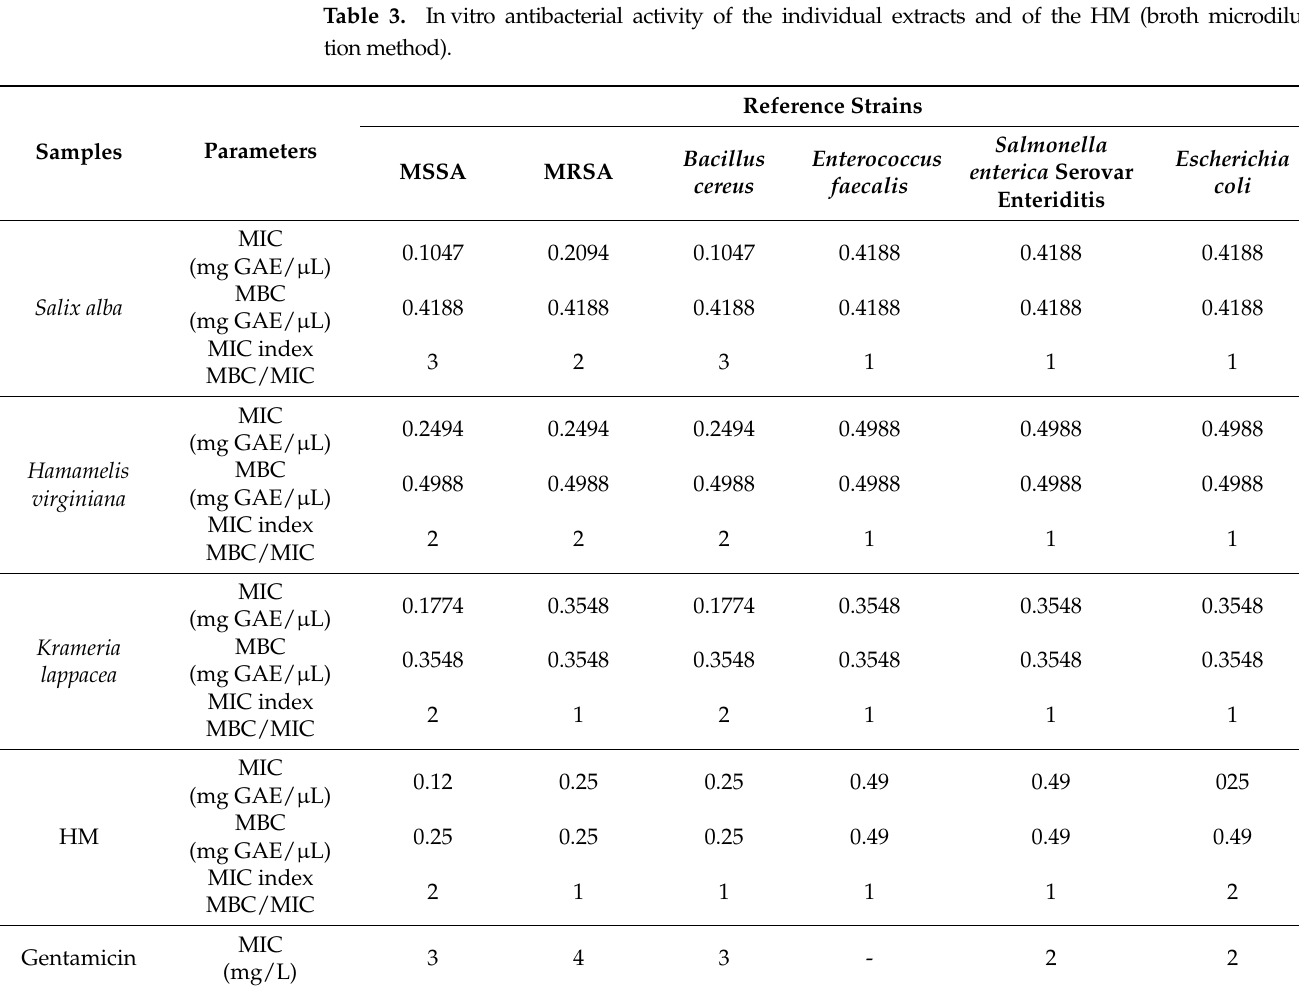
Table 3. In vitro antibacterial activity of the individual extracts and of the HM (broth microdilu- tion